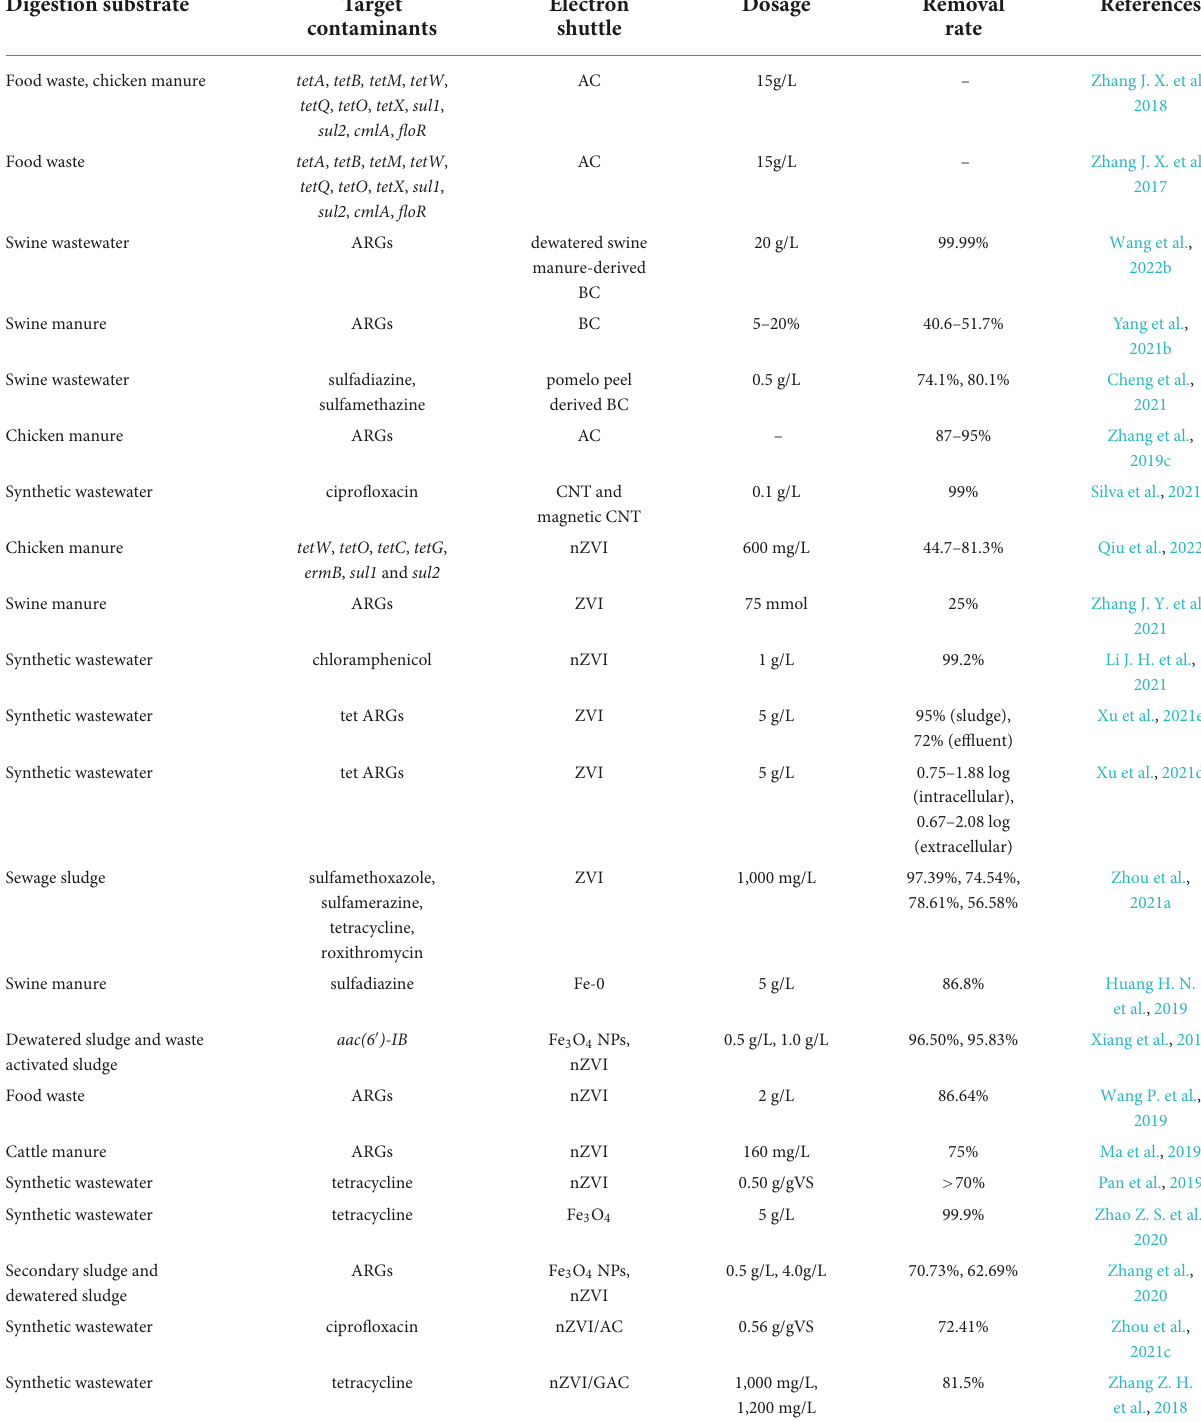
TABLE 1 Summary of research on removal of antibiotics and ARGs by enhanced anaerobic biological treatment with electron shuttles. Digestion